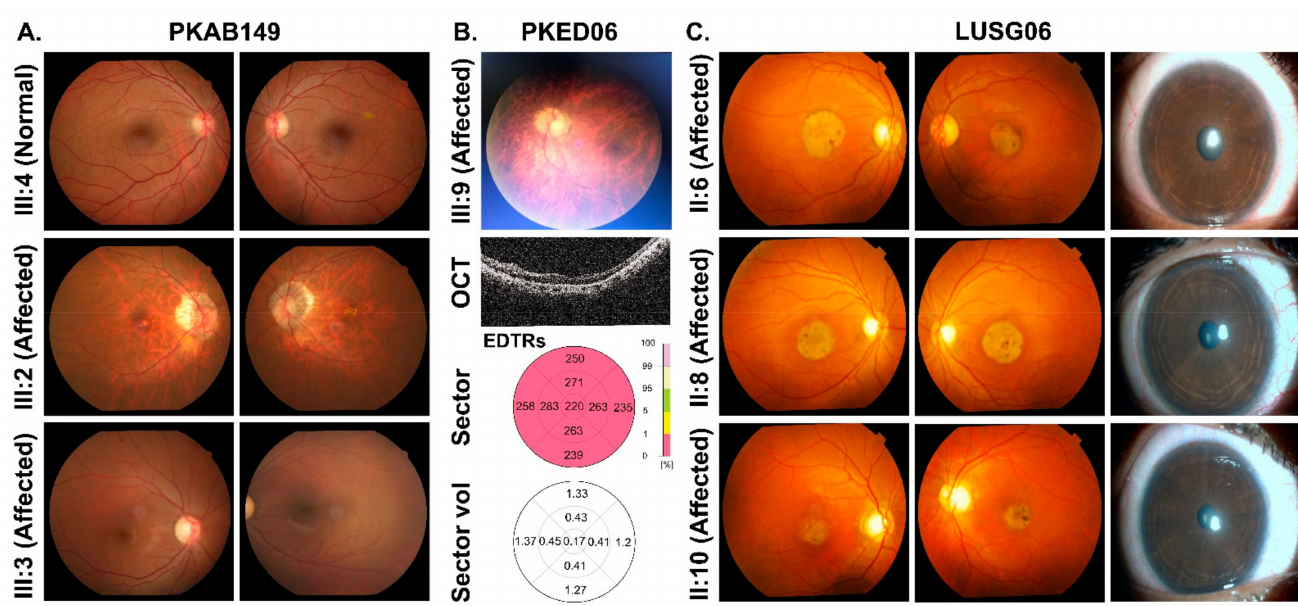
Figure 2. ( A ) Fundoscopy images of family PKAB149. ( B ) Representative image of one of the affected individuals of family PKED06 along with its OCT (middle panel) and retinal thickness map (bottom panel), showing average of retinal thickness measurements. ( C ) Fundoscopic (left) and slit lamp (right) images of affected individuals of family